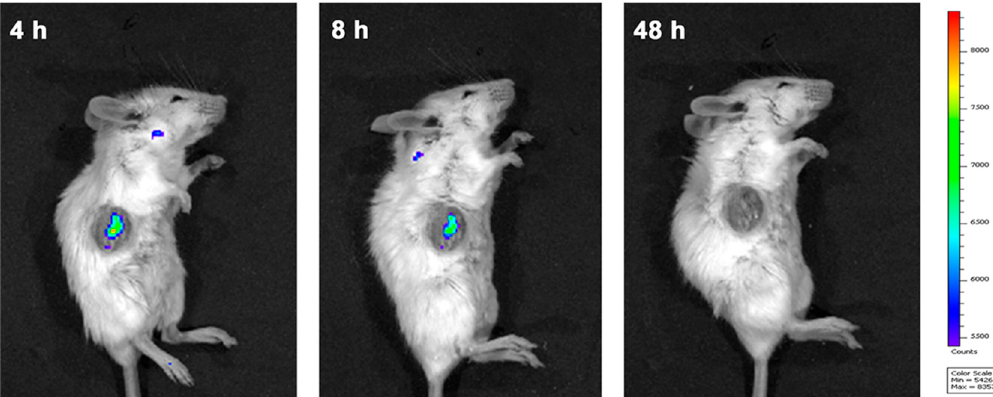
Figure 8. The cell viability of 4T1 cells incubated with QICY at different concentrations and irradi- ated by 630 nm laser (Laser power density: 20 mW/cm 2 ; Irradiation time: 5 or 10 min).